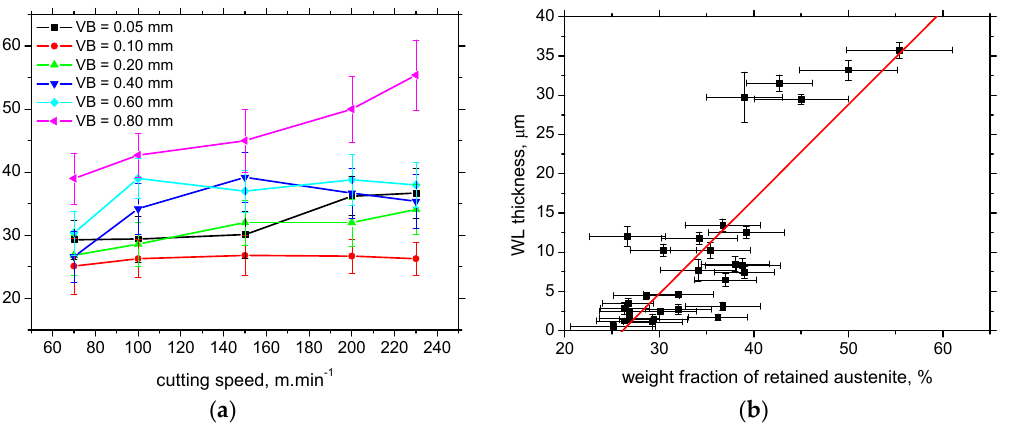
Figure 9. Evolution of surface austenite fraction and its correlation with WL thickness (bulk austenite fraction 22 ± 3.2): ( a ) surface austenite fraction along cutting speed; ( b ) austenite fraction versus WL thickness (correlation coefficient 0.83).